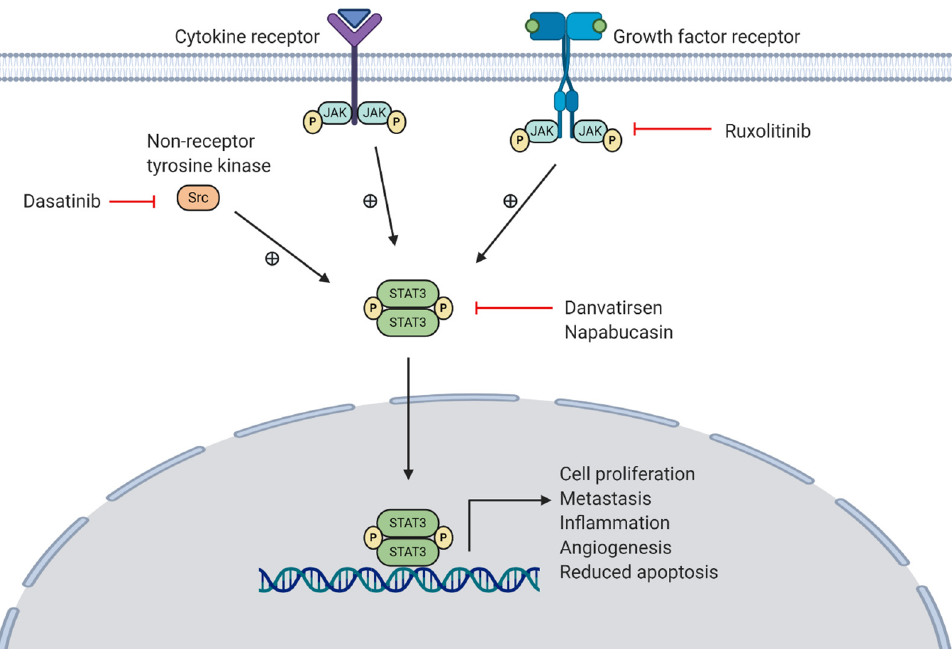
Figure 4. Overview of STAT3 activation via the JAK-STAT pathway (cytokine and growth factor receptor stimulation) and cytoplasmic Src kinase. A JAK inhibitor (ruxolitinib), STAT3 inhibitors (danvatirsen, napabucasin) and a Src inhibitor (dasatinib) are currently in clinical trials for pancreatic cancer.